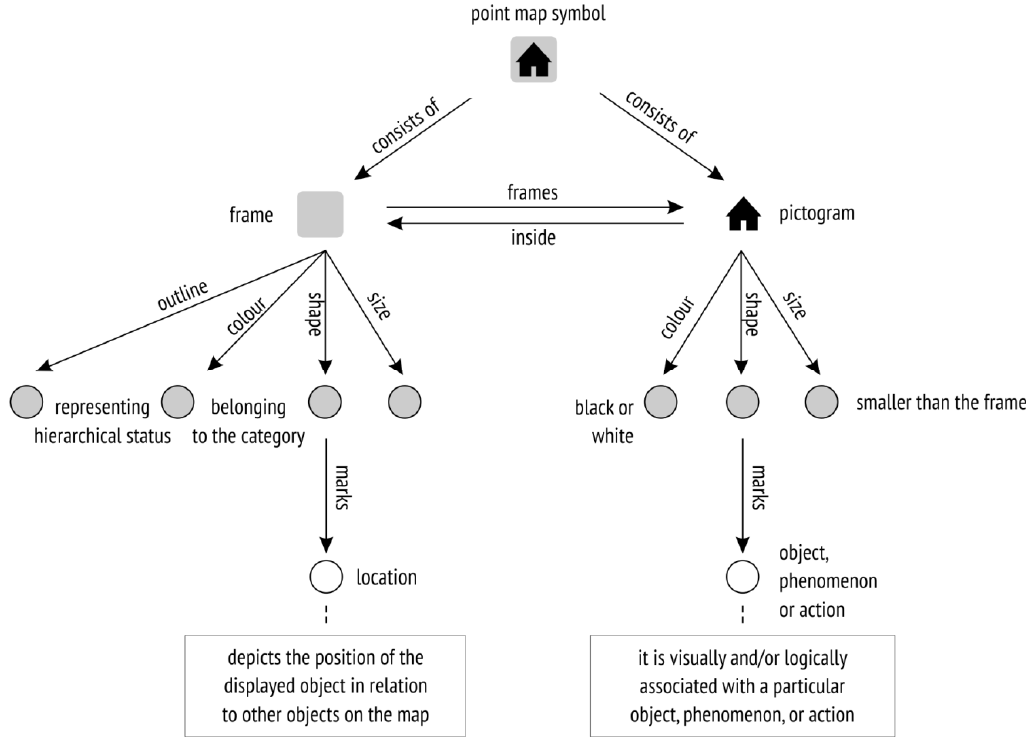
Figure 9. Cognitive scheme describing possible pattern of thinking and behaviour of users in the interpretation of cartographic symbols for crisis mapping. interpretation of cartographic symbols for crisis